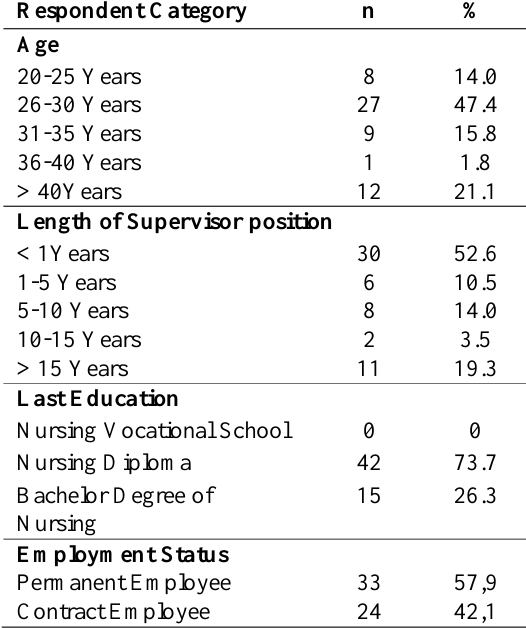
Table 1. Respondent characteristics